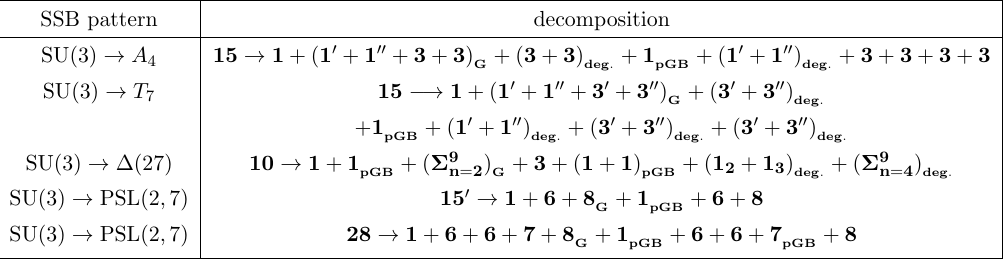
Table 16 . Scalar mass eigenstates for the SSB patterns SU(3) ! A 4 ; T 7 , (cid:1)(27) and PSL(2 ;